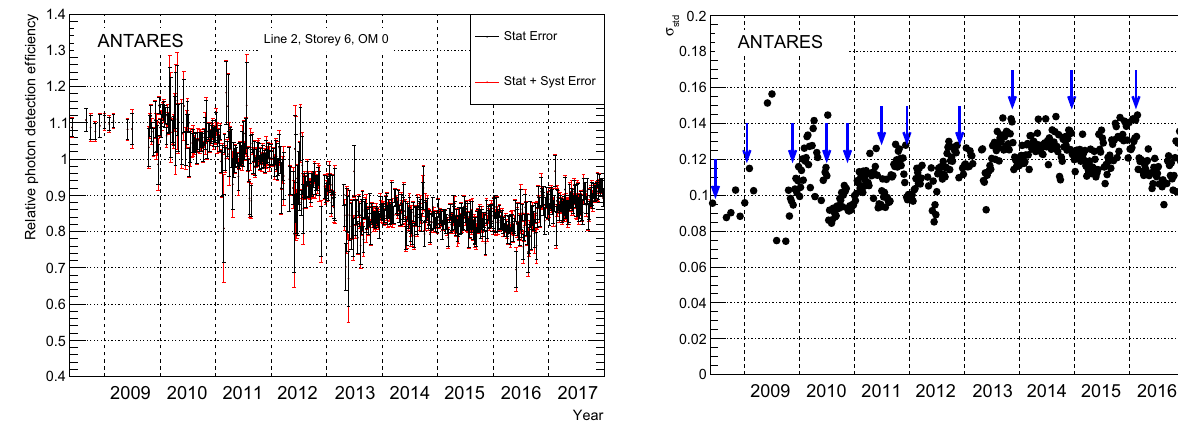
The distribution of the detected charge is regularly